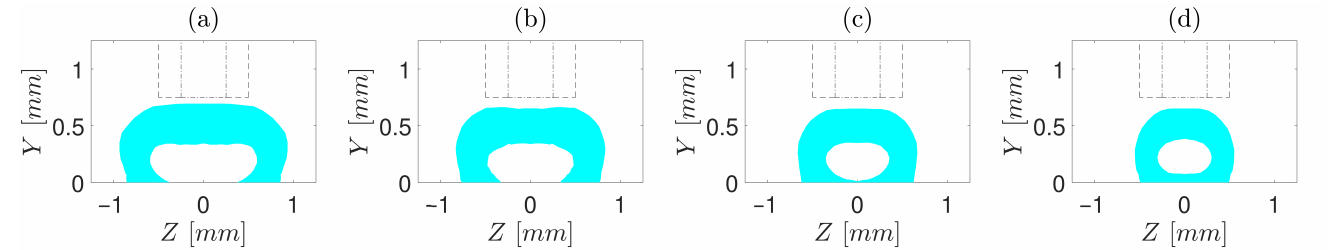
Figure 5. Cross-sections of the core–shell strand for t / D = 0.75, d / D = 0.5 and different V / U of ( a ) 0.5, ( b ) 0.75, ( c ) 1, and ( d ) 1.25. Core diameter and orifice are marked by “- -” and “-·”, respectively.